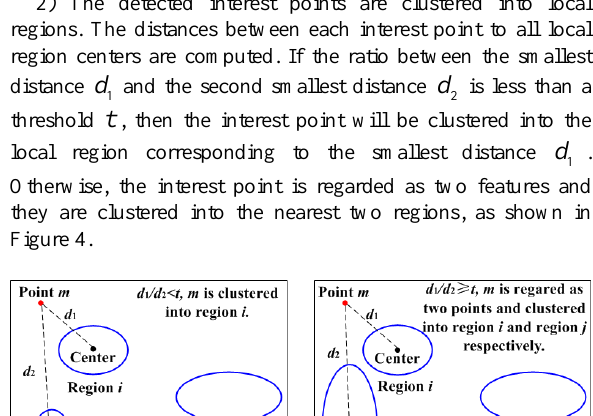
Figure 5. The flowchart of feature area